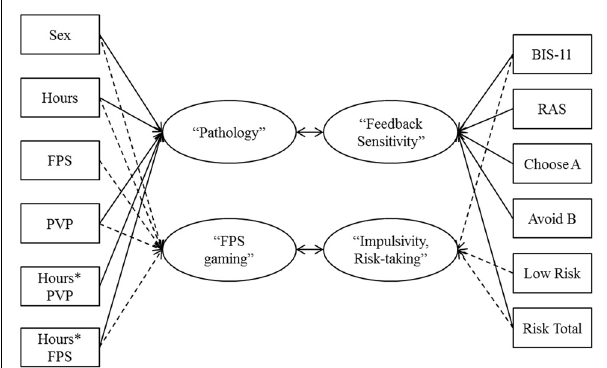
FIGURE 4 | Graphical representation of the significant canonical functions and the strongest contributing predictors (left side) and dependent variables (right side). Solid lines represent the first canonical function and dashed lines represent the second canonical function.